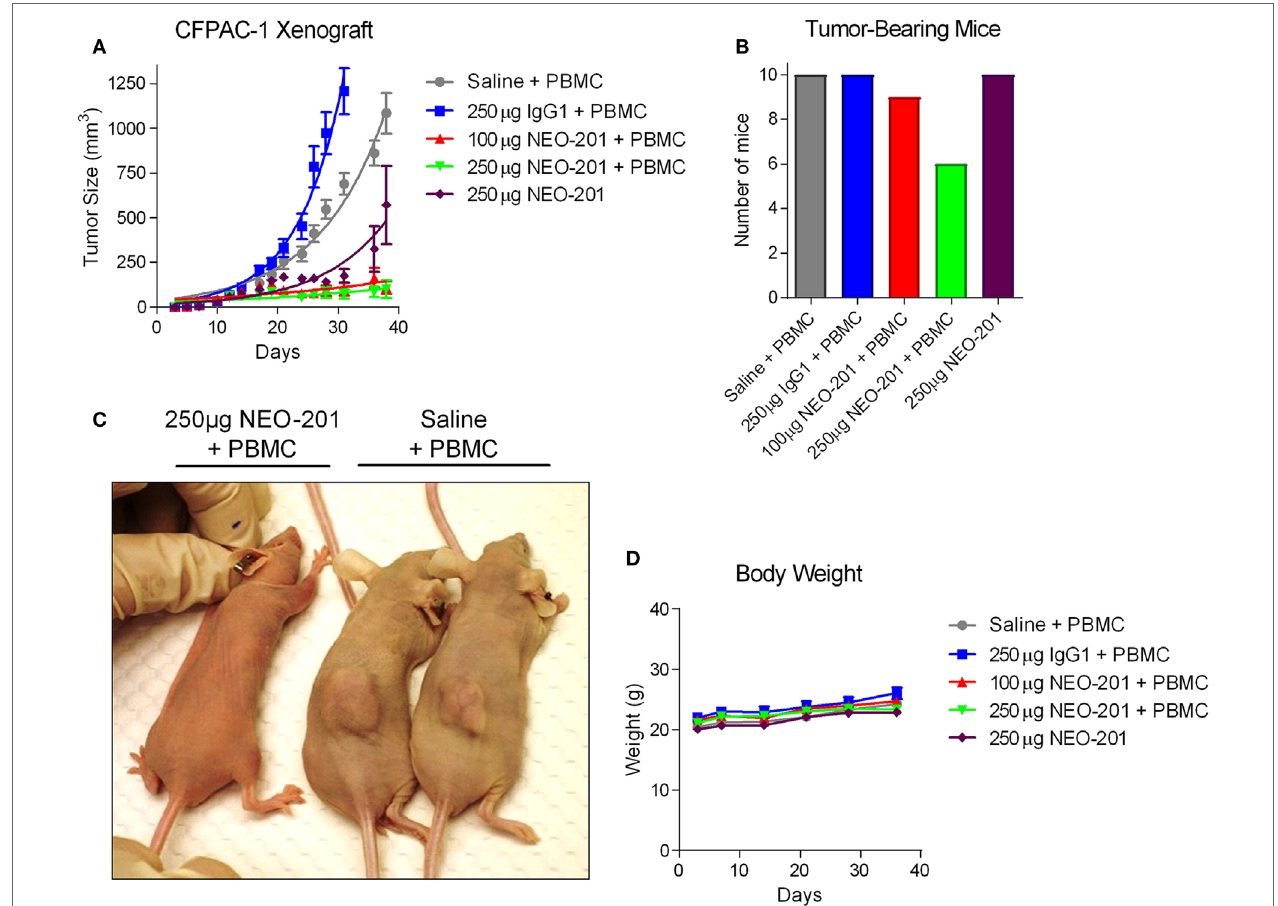
FigUre 4 | Antitumor efficacy of NEO-201 in CFPAC-1 tumor xenografts. (a) Tumor volume measurements for the CFPAC-1 xenografts from each treatment group at various time points. Mice ( n = 10 animals/group) were dosed intraperitoneally with saline solution, human IgG1 (250 µg), or NEO-201 (100 and 250 µg) on days 13, 17, and 20 post-tumor cell implantation. Mice were also dosed intraperitoneally with ~1.0 × 10 7 IL-2-activated human peripheral blood mononuclear cells (PBMCs) on days 14, 18, and 21 as a source of immune effector cells. (B) Quantification of the number of mice still bearing palpable tumors on day 36. (c) Representative image of NEO-201-treated versus saline-treated tumor-bearing mice. (D) Body weight measurements of the tumor-bearing mice at various time points during the